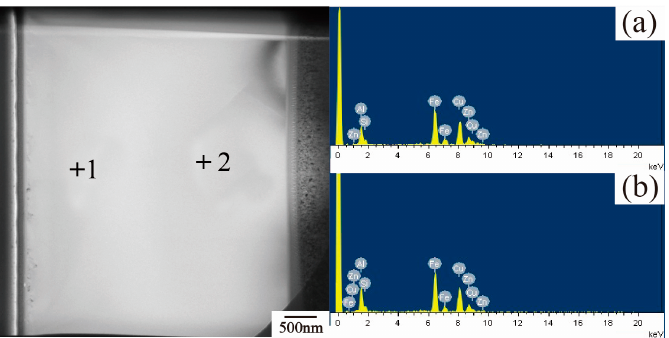
Figure 13. SEM images of a TEM film obtained using FIB: ( a ) Found a region, ( b ) Rough cutted, ( c ) Cutted off the sample and extracted it, ( d ) Transmitted it to the TEM copper target and using a FIB for the preparation of an ultra-thin sample.